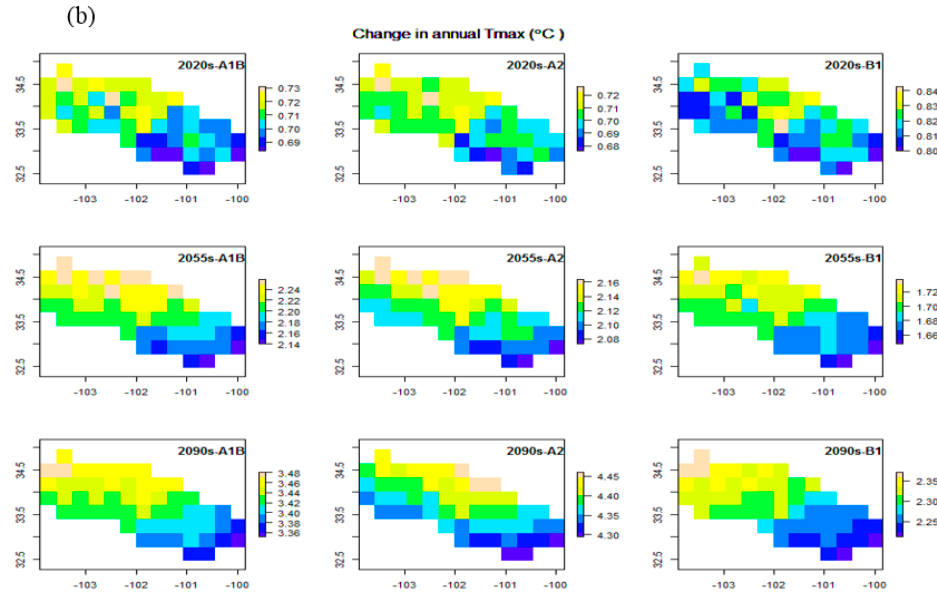
Figure 6. Spatial variability of average annual Tmin ( a ) and Tmax ( b ) compared with the baseline (maps are not to scale).